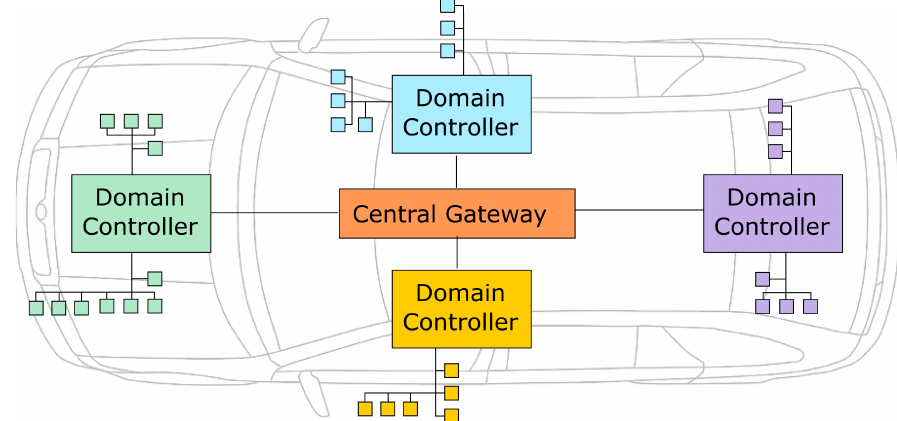
Figure 1. Example of domain-based